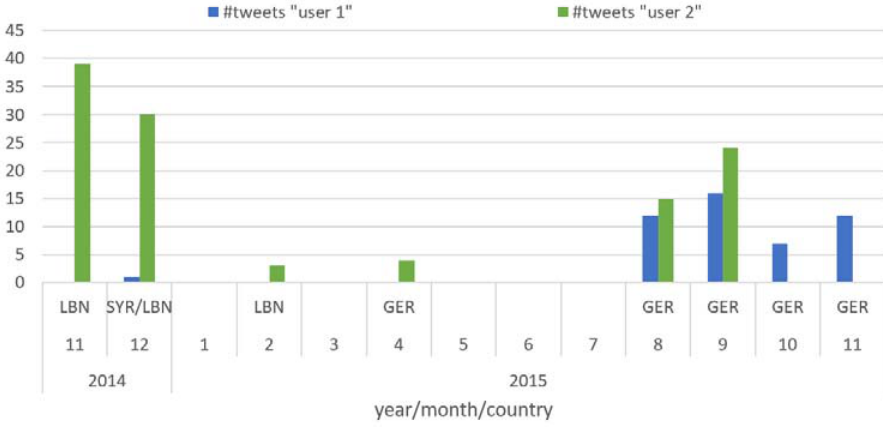
Figure 9. Twitter activity of likely refugees moving from the Middle East to Germany.